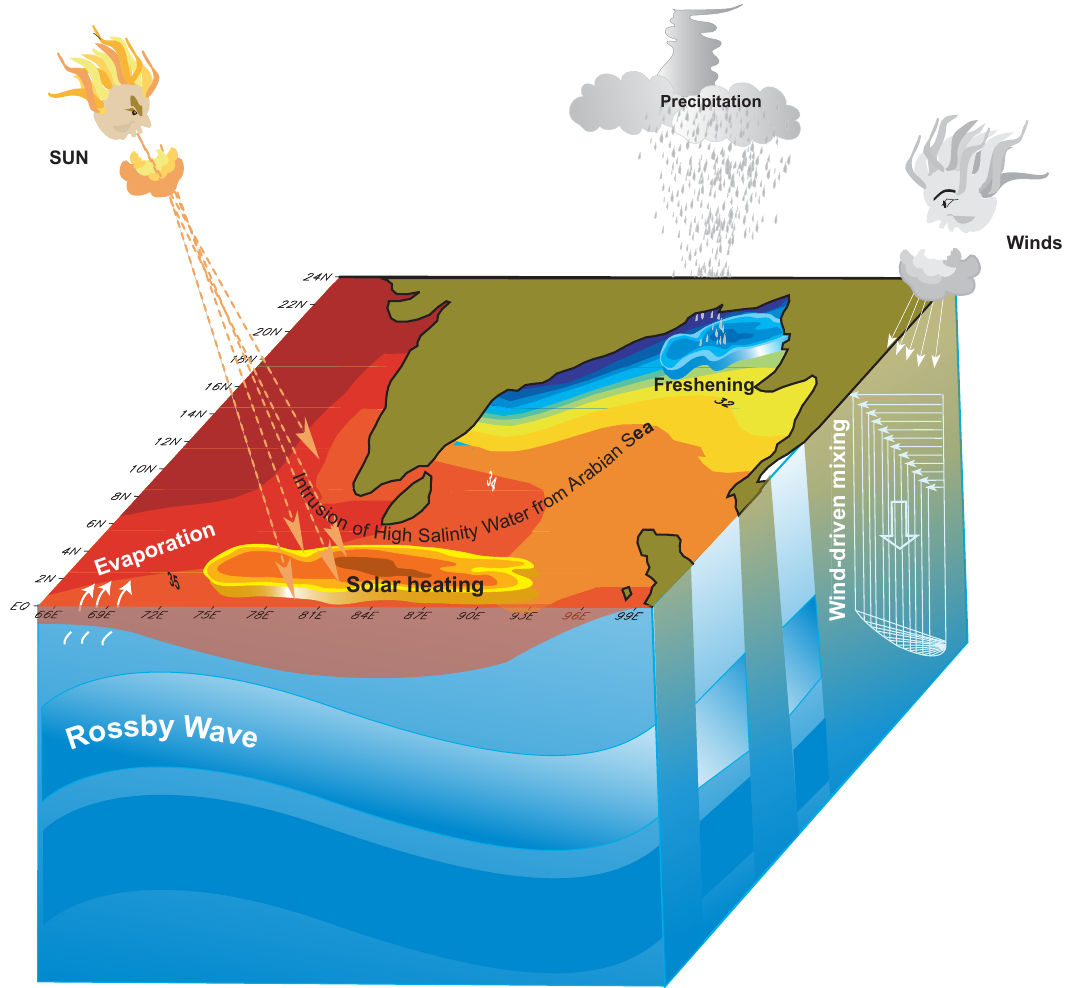
Figure A9. Schematic representation of local and remote forcings that influence the depth of the mixed layer. Colour shading is the climato- logical monthly mean salinity for August from WOA05 (Antonov et al., 2006) showing the intrusion of high salinity waters from the Arabian Sea. The local forcing that affect the MLD are the precipitation and river runoff, solar heating, and wind mixing. The remote forcings are the intrusion of high salinity waters from the Arabian Sea and propagation of Rossby